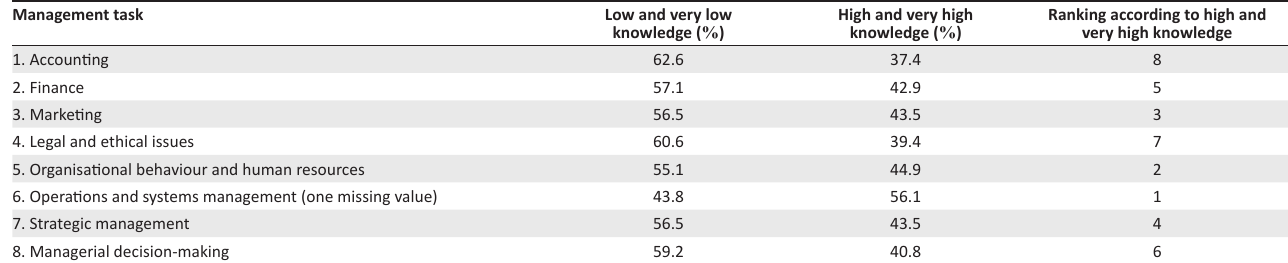
TABLE 2: Existing levels of knowledge ( n = 147). Management task Low and very low